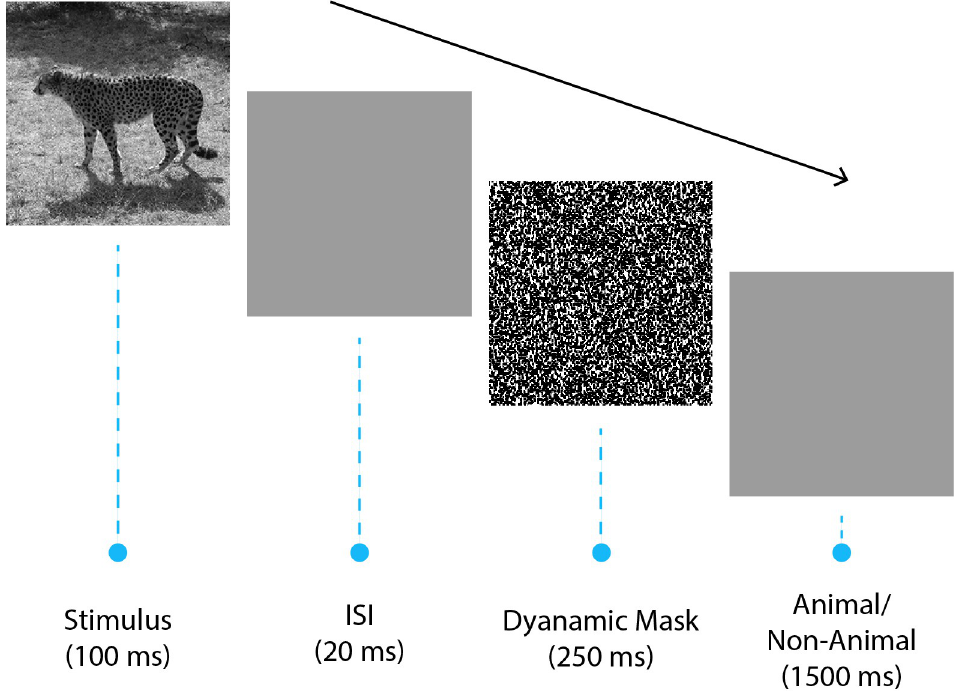
Fig 1. The EEG task. The EEG experiment contained 13 experimental runs; in each run, 32 natural images (16 animal, 16 non-animal) were presented to the participant in a random order. Each image was shown for 100 ms, followed by an inter-stimulus interval (ISI) of 20ms and a dynamic noise mask for 250ms. Participants were given 1500 ms to indicate (using pre-specified buttons) whether the presented image contained an animal or not.